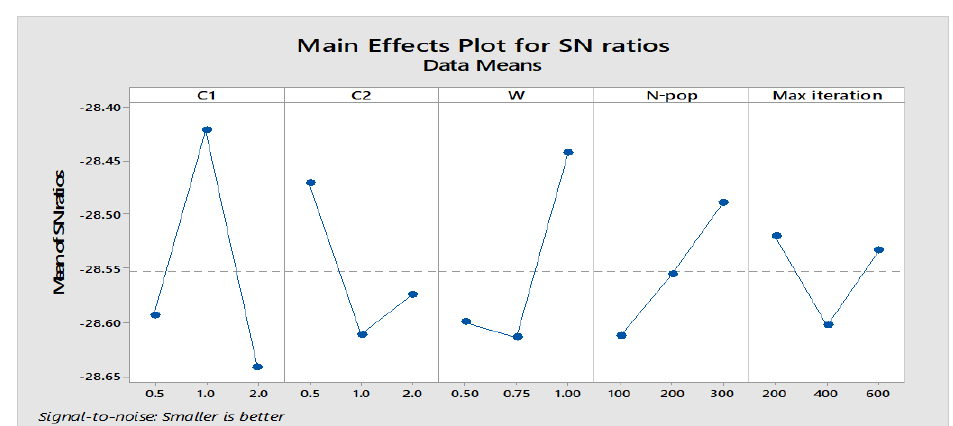
Figure 5. The Signal-to-Noise plots for PSO